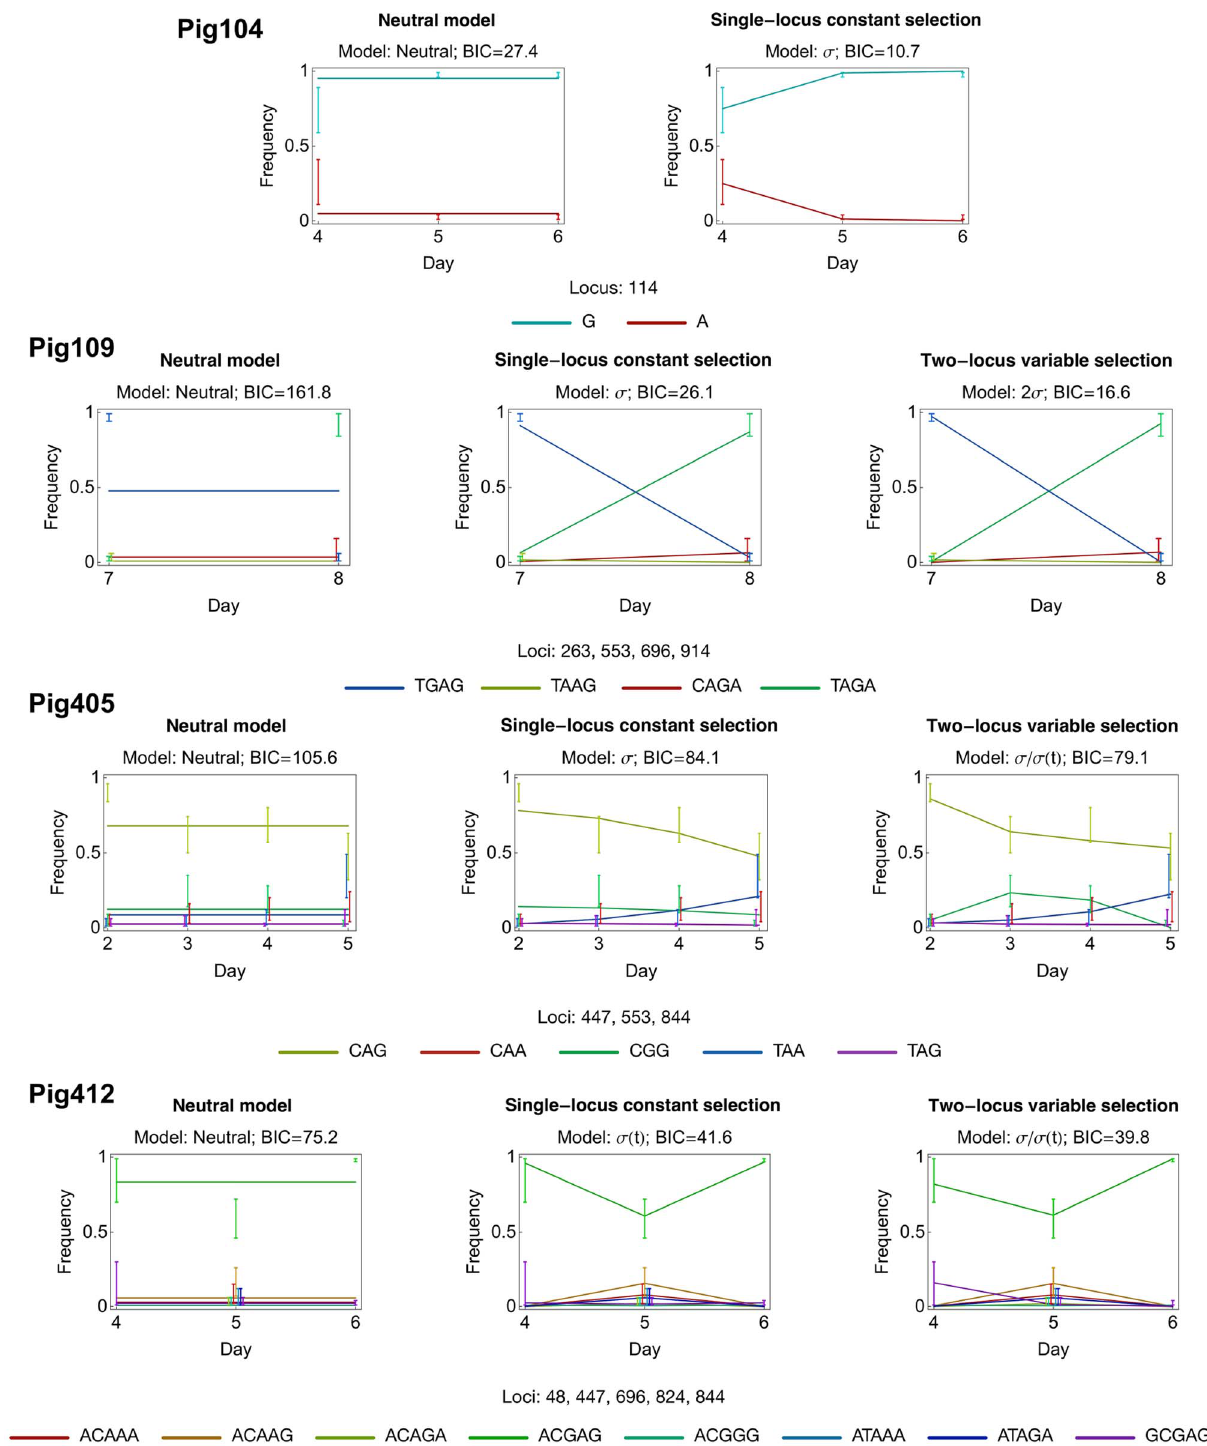
Figure 3. Representative haplotype frequency plots for different models of selection. Comparative model fits for Pig104: A model of constant selection against the G R A mutation at locus 113 outperforms the neutral model, Pig109: A model in which two of three mutations at loci 553, 696, and 914 outperforms models in which one or none of these mutations is under selection. Pig405: A two-locus selection model of constant selection for the G R A mutation at locus 844, with variable, decreasing selection for the A R G mutation at locus 553 gave the best fit to the data. Pig412: A model of time-dependent selection at the locus 696, with constant negative selection at locus 48 was optimal. Coloured error bars show 95% confidence intervals for the marginal frequency of each haplotype given the observation; error bars are offset from their respective time-points to allow their identification. Inferences are shown only for haplotypes that were observed in the sequence data. In Pig405 the CAA haplotype frequency is obscured below the TAA